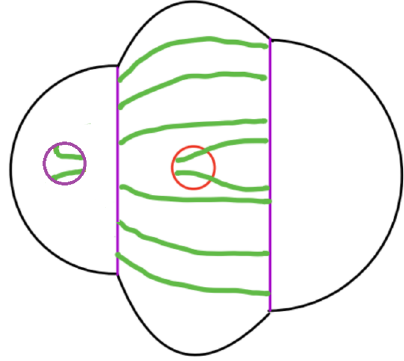
Figure 9 . Bit-thread diagram for asymmetric black hole